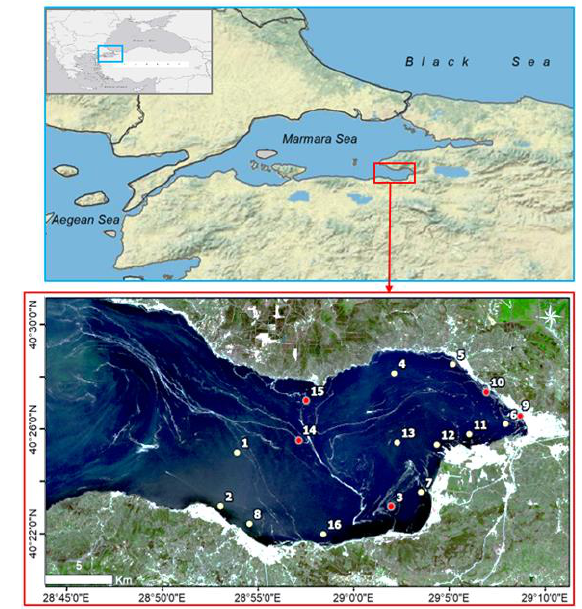
Figure 1. The map of the Gulf of Gemlik and distribution of 16 in-situ sampling points (red dots are mucilage samples) in Sentinel-2 satellite image (© Copernicus).